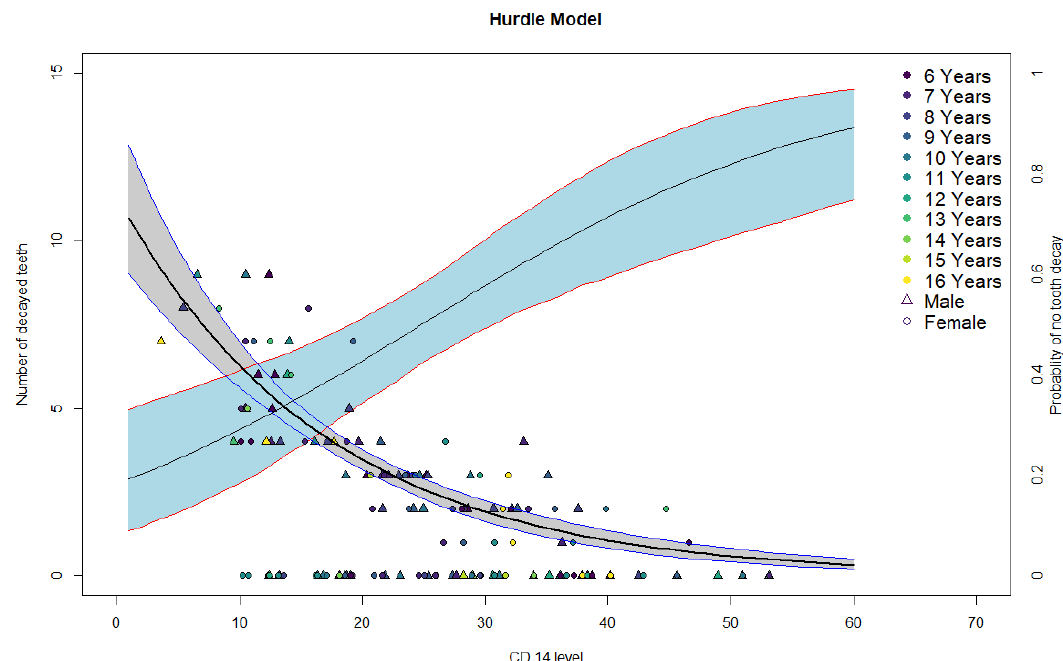
Figure 2. Plot of hurdle model results, triangles are male subjects and females are circles, subjects are colored by age. The light blue band with red borders is the 95% CI of the probability estimate of being in the H group, the grey band is the 95% CI of the estimate of expected number of lesions in relation to sCD14 levels.